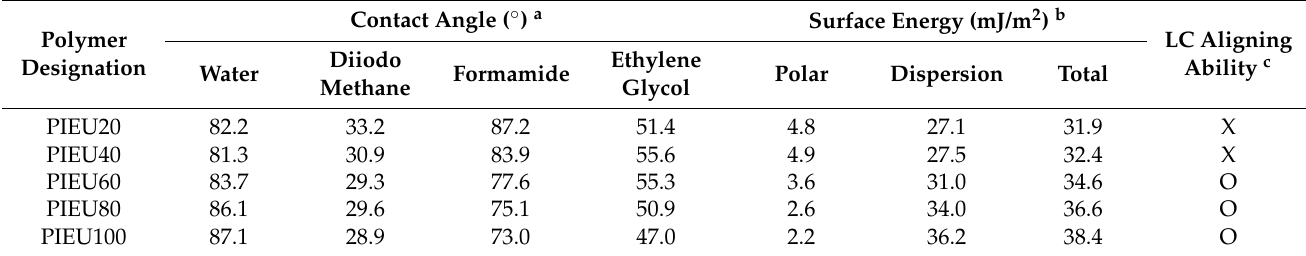
Table 2. Surface energy values and liquid crystal (LC) alignment properties.